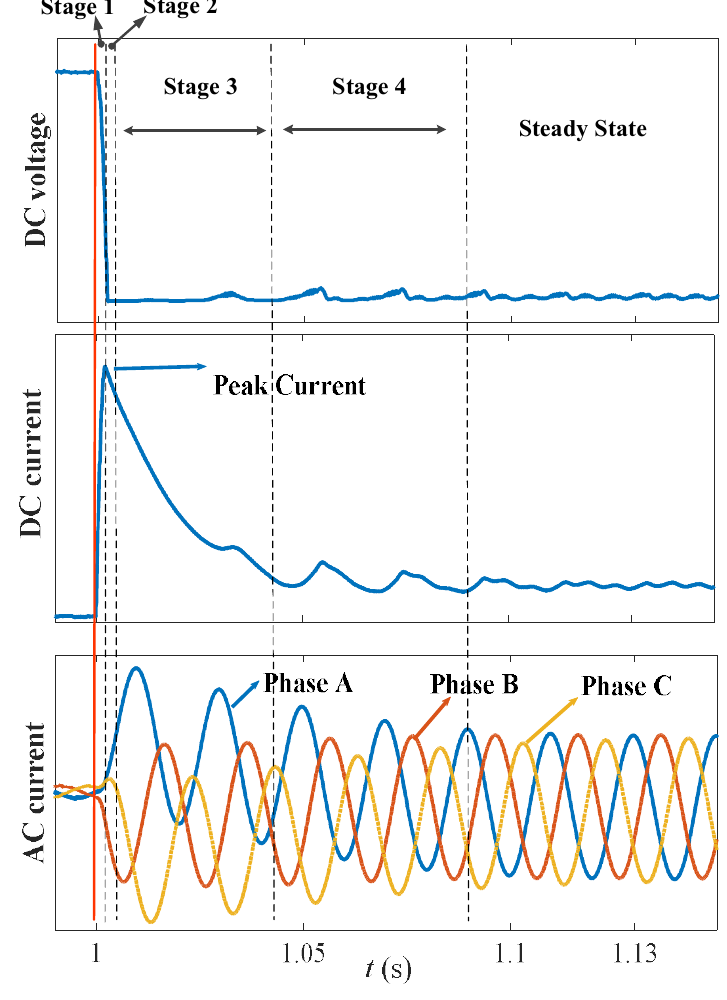
Figure 5. Fault characteristics for voltage source converter (VSC) during a pole-to-pole fault.